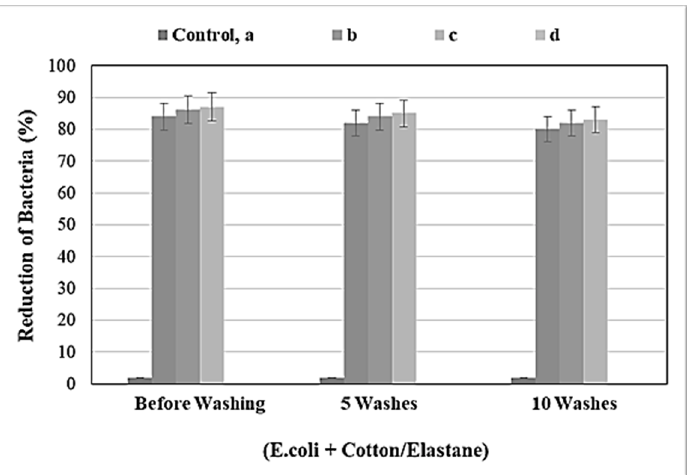
Figure 2. Antibacterial activities using Escherichia coli ( E. coli ) ATCC 25922 based on one-way ANOVA ( p < 0.01). a: untreated; b: 10 wt % CaCl 2 ; c: 25 wt % CaCl 2 ; d: 50 wt % CaCl 2 . The data are represented as mean ± SD.